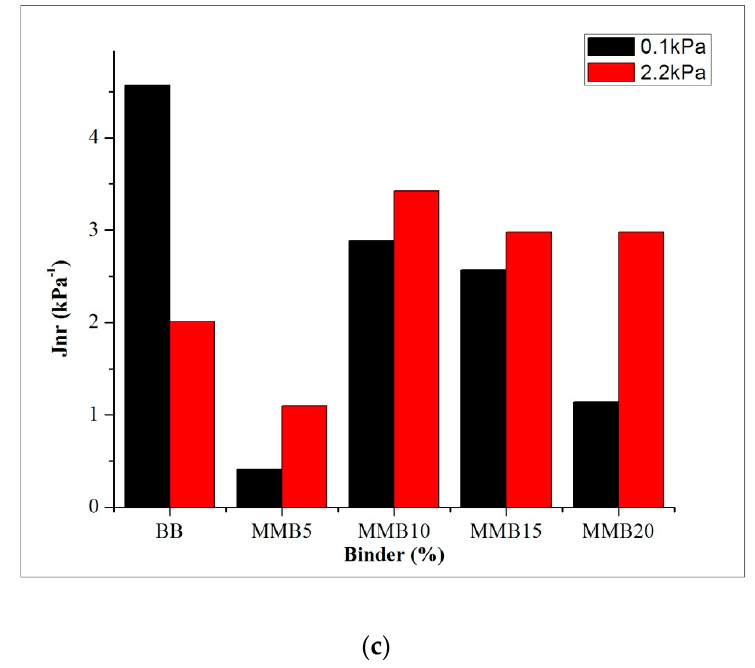
Figure 12. Noncompliance (J nr ) evaluations at ( a ) 52 ◦ C, ( b ) 58 ◦ C, and ( c ) 64 ◦